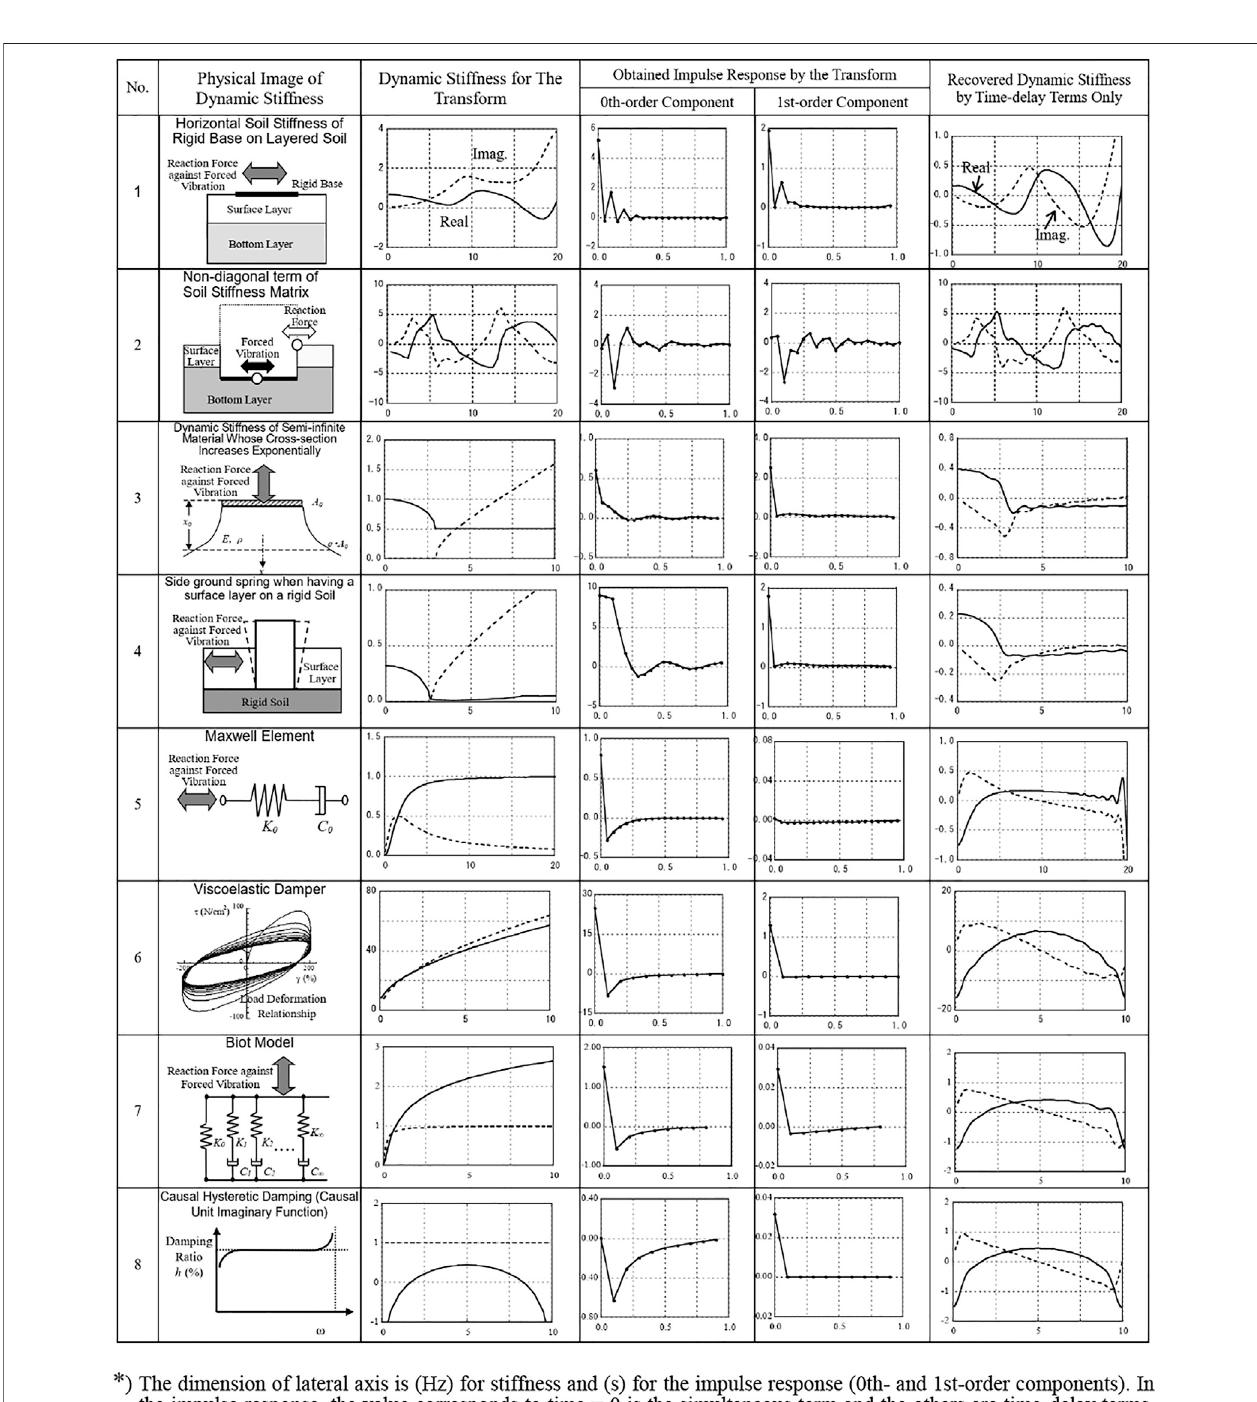
FIGURE1| Typicaltransform examplesfortime-domaintransform.*Thedimensionoflateralaxisis(Hz)forstiffnessand(s)fortheimpulseresponse(0th-and1st- order components). In the impulse response, the value corresponds to time = 0 is the simultaneous term and the others are time-delay terms. The dimension of vertical axis is stiffness (N/m) for Nos. 1 – 7 and dimensionless for No. 8.